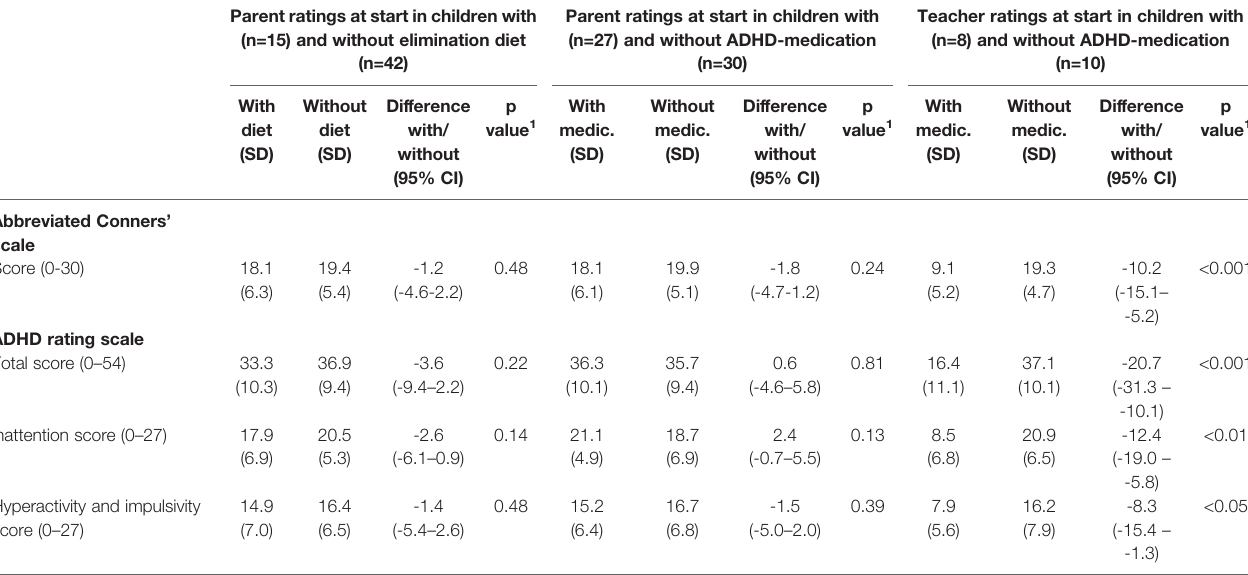
TABLE 2 | Comparison of behavioral scores at start in children with and without elimination diet (parent ratings) or attention-de fi cit/hyperactivity disorder (ADHD) – medication (parent and teacher ratings). Parent ratings at start in children with Parent ratings at start in children with Teacher ratings at start in children with (n=15) and without elimination diet (n=27) and without ADHD-medication (n=8) and without (n=42) (n=30)